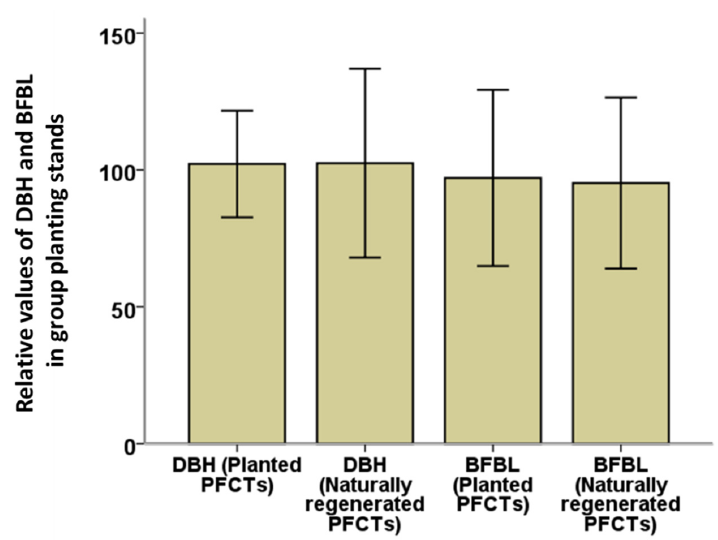
Figure 5. Relative DBH and branch free bole length (BFBL) of potential future crop trees (PFCTs) in group planting stands when compared to and row planting. A value of 100 means no difference between group and row planting. The bars represent standard error at the level of 95% confidence ( n = five pairs of group and row planting stands). The mean DBH and BFBL did not differ significantly between group and row planting stands.